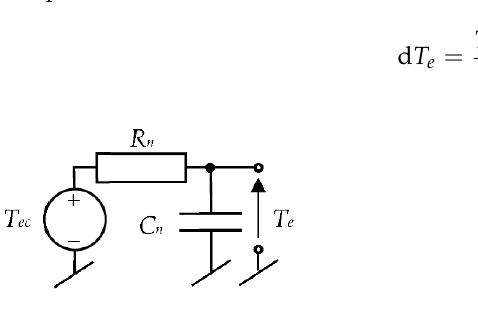
Figure 9. Thermal model of the sensor.